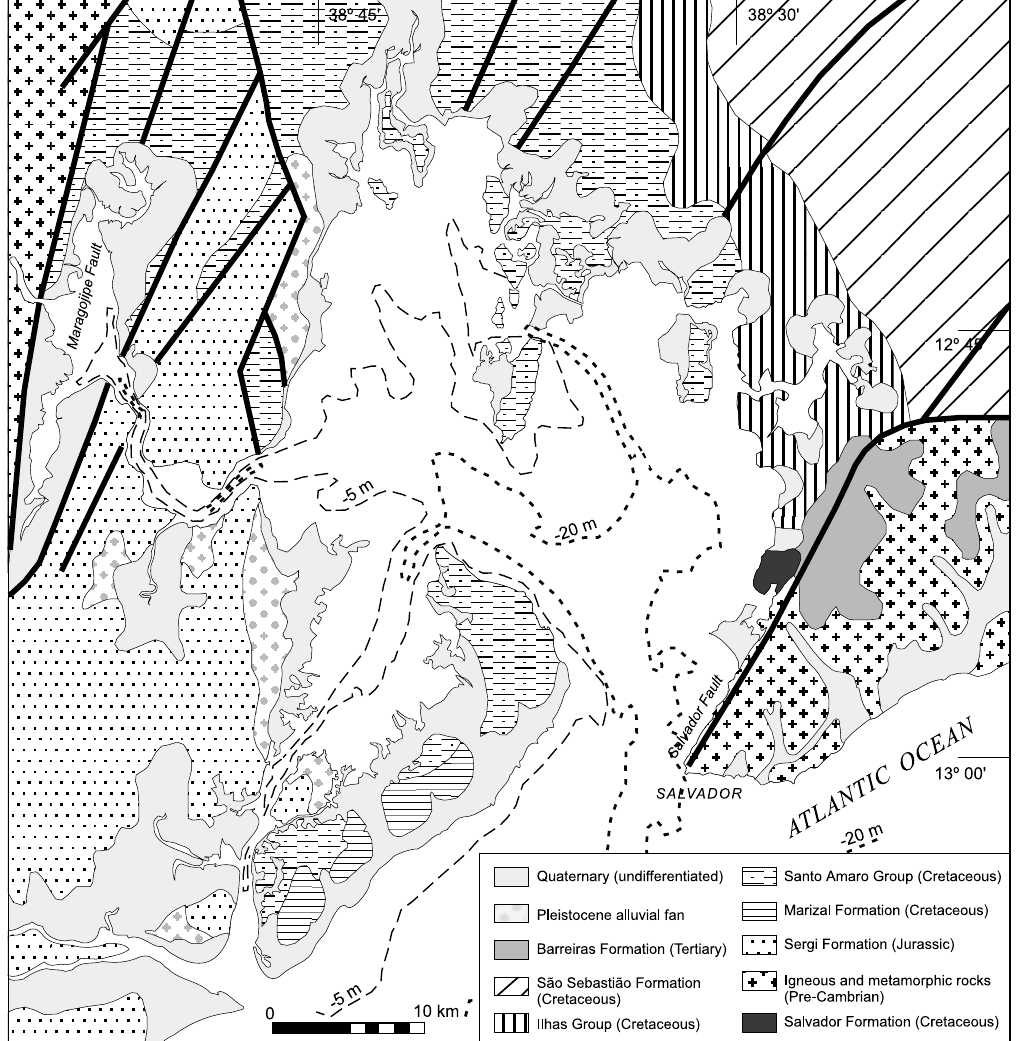
Fig. 2 – Geology map of the surroundings of Todos os Santos Bay (after Medeiros & Ponte 1981) and the general bathymetric contour of Todos os Santos Bay (source: DHN’s nautical chart